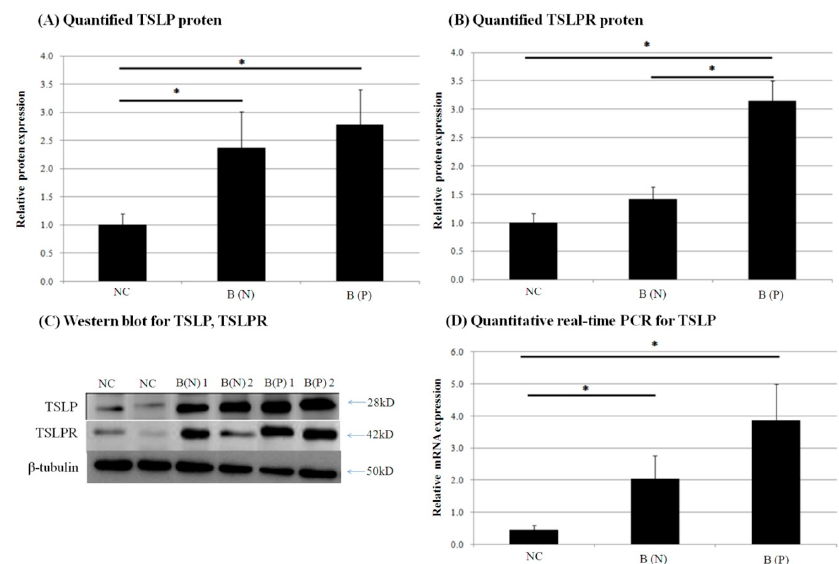
Figure 6. Expression of ( A ) thymic stromal lymphopoietin (TSLP) protein and ( B ) TSLP receptor (TSLPR) protein in normal and burn-scar tissues with or without pruritus was measured by ( C ) western blotting (WB). Expression of ( D ) TSLP mRNA was measured using quantitative real-time PCR in normal and burn-scar tissues with or without pruritus. The greatest TSLP expression of mRNA and protein was observed in pruritic burn-scar tissue using qPCR and western blotting ( A – C ). TSLPR proteins were also highest in pruritic burn-scar tissue via western blotting results ( D ). NC: keratinocytes from normal control; B (N): keratinocytes from nonpruritic burn scar; B (P): keratinocytes from pruritic burn scar; TSLP: thymic stromal lymphopoietin; TSLPR: thymic stromal lymphopoietin receptor; Error bars: standard deviation of the mean value obtained from three experiments, each performed in triplicate. * p < 0.001.